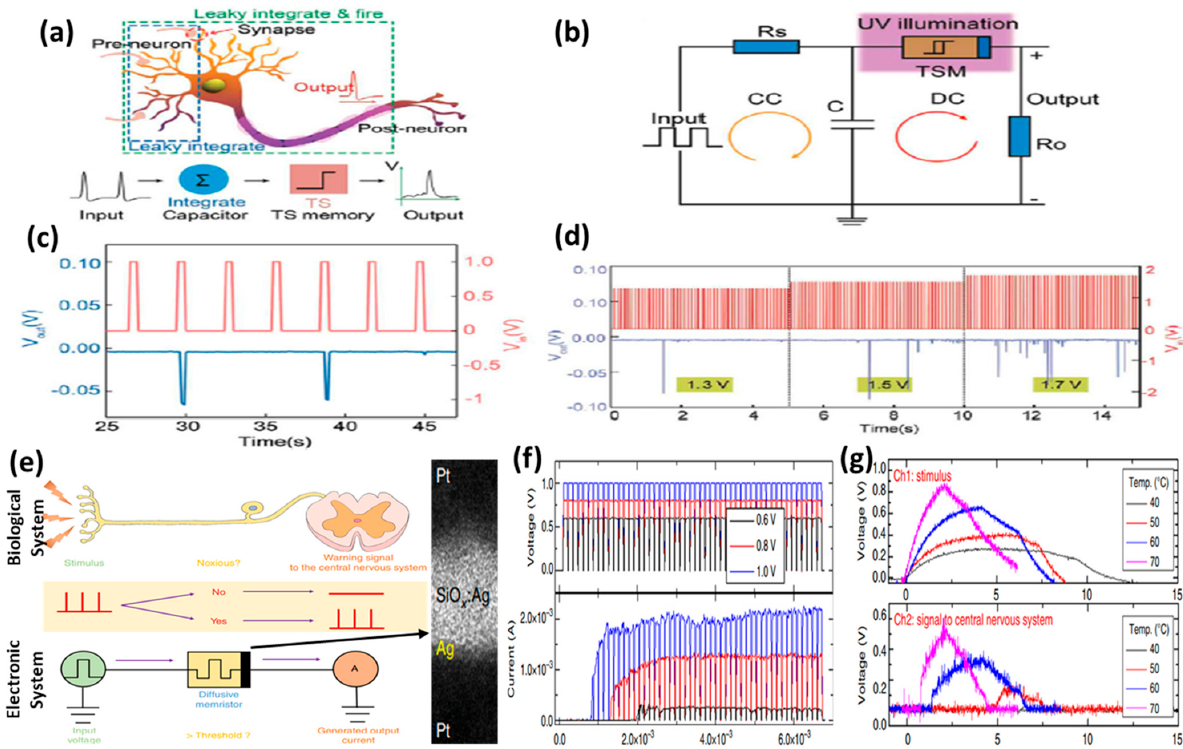
Figure 13. Emulation of biological neurons with CBRAM devices. ( a ) Schematic illustration of LIF mechanism in a biological neuron and artificial neuron. ( b ) Schematic of LIF neuron circuit. ( c ) The output signal of the LIF neuron circuit corresponding to successive input pulses. ( d ) The output spikes under voltage pulses with different pulse amplitudes. Reprinted from Ref. [82]. ( e ) Schematic illustration of the mechanisms of a biological nociceptor and an artificial nociceptor implemented with a diffusive memristor. A cross-sectional TEM image of the diffusive memristor is on the right. ( f ) Response of the device to multiple pulses with different amplitudes. ( g ) The generated voltage from the thermoelectric module for different temperatures and the response of the device to each voltage presenting a successful implementation of a thermal nociceptor. Reprinted from Ref. [84].